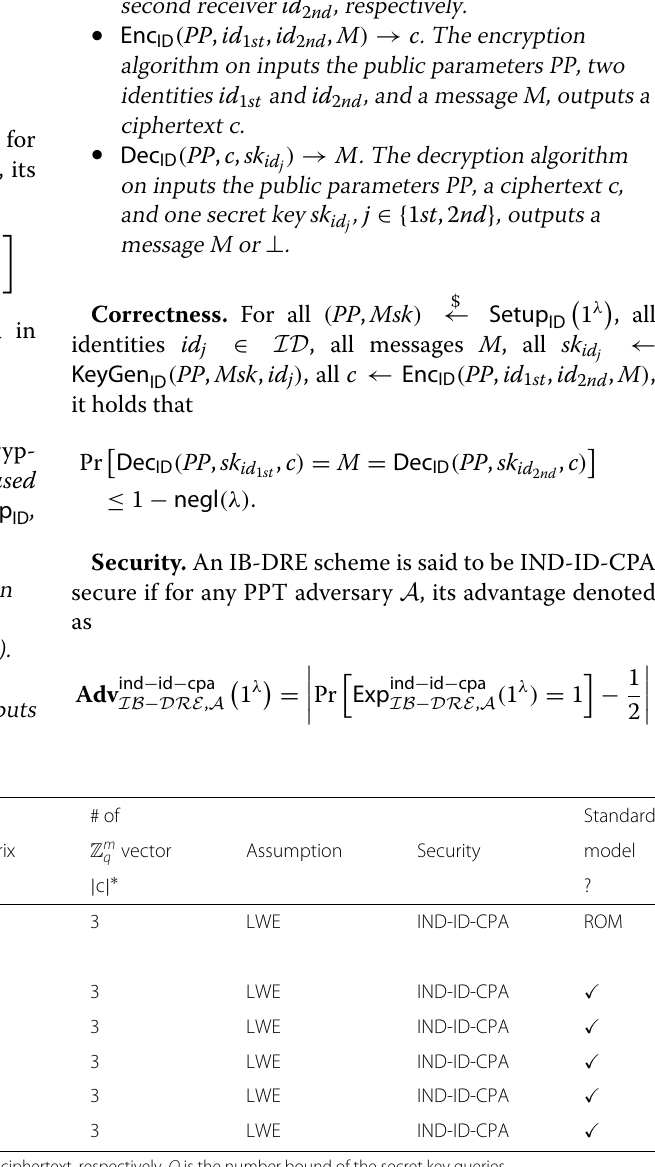
algorithmoninputsthepublicparametersPP,two